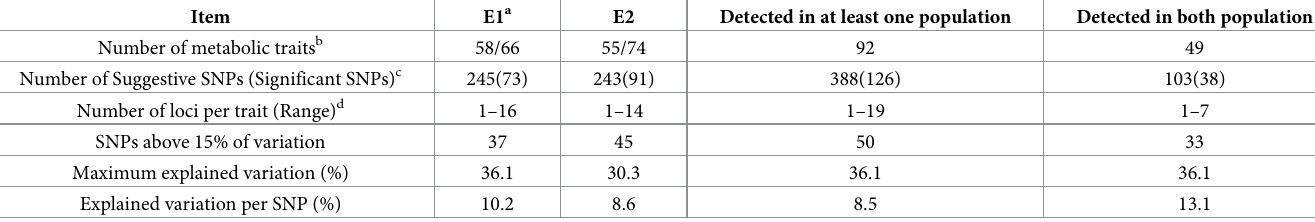
Table 1. Summary of significant loci–trait associations identified in GWAS population.